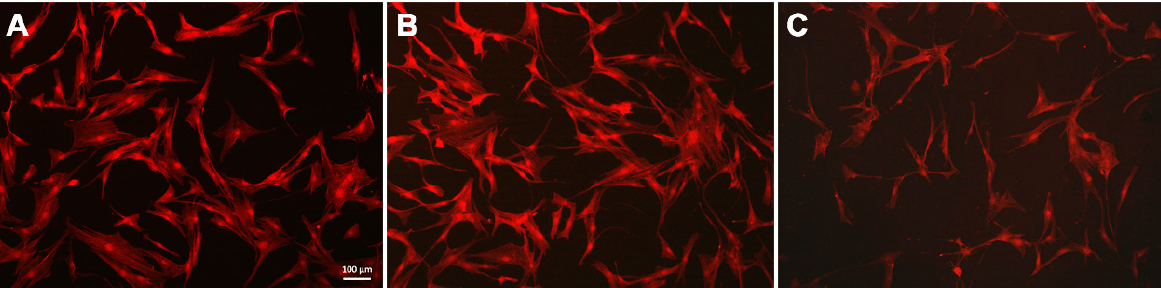
Figure 5. Fluorescent images of hTERT-transduced MSCs with stained cytoskeleton: ( А ) glass, ( B ) MNPs@DNA 3 mg/mL and ( C ) MNPs@DNA 6 mg/mL. F-actin stained with phalloidin (red).